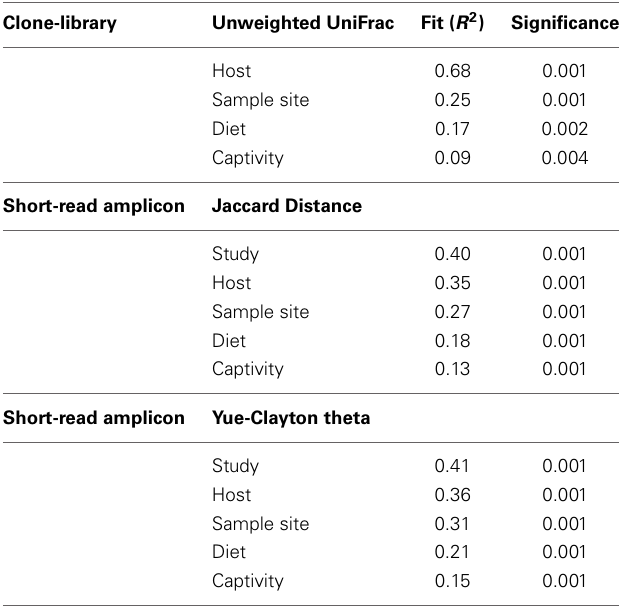
Table 3 | Calculated fit of metadata factors to community distances using PERMANOVA with linear model